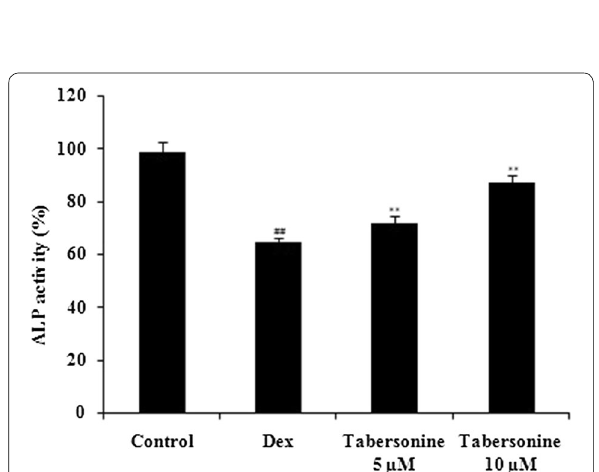
Fig. 2 Effect of tabersonine on osteoblast alkaline phosphatase activity. Means